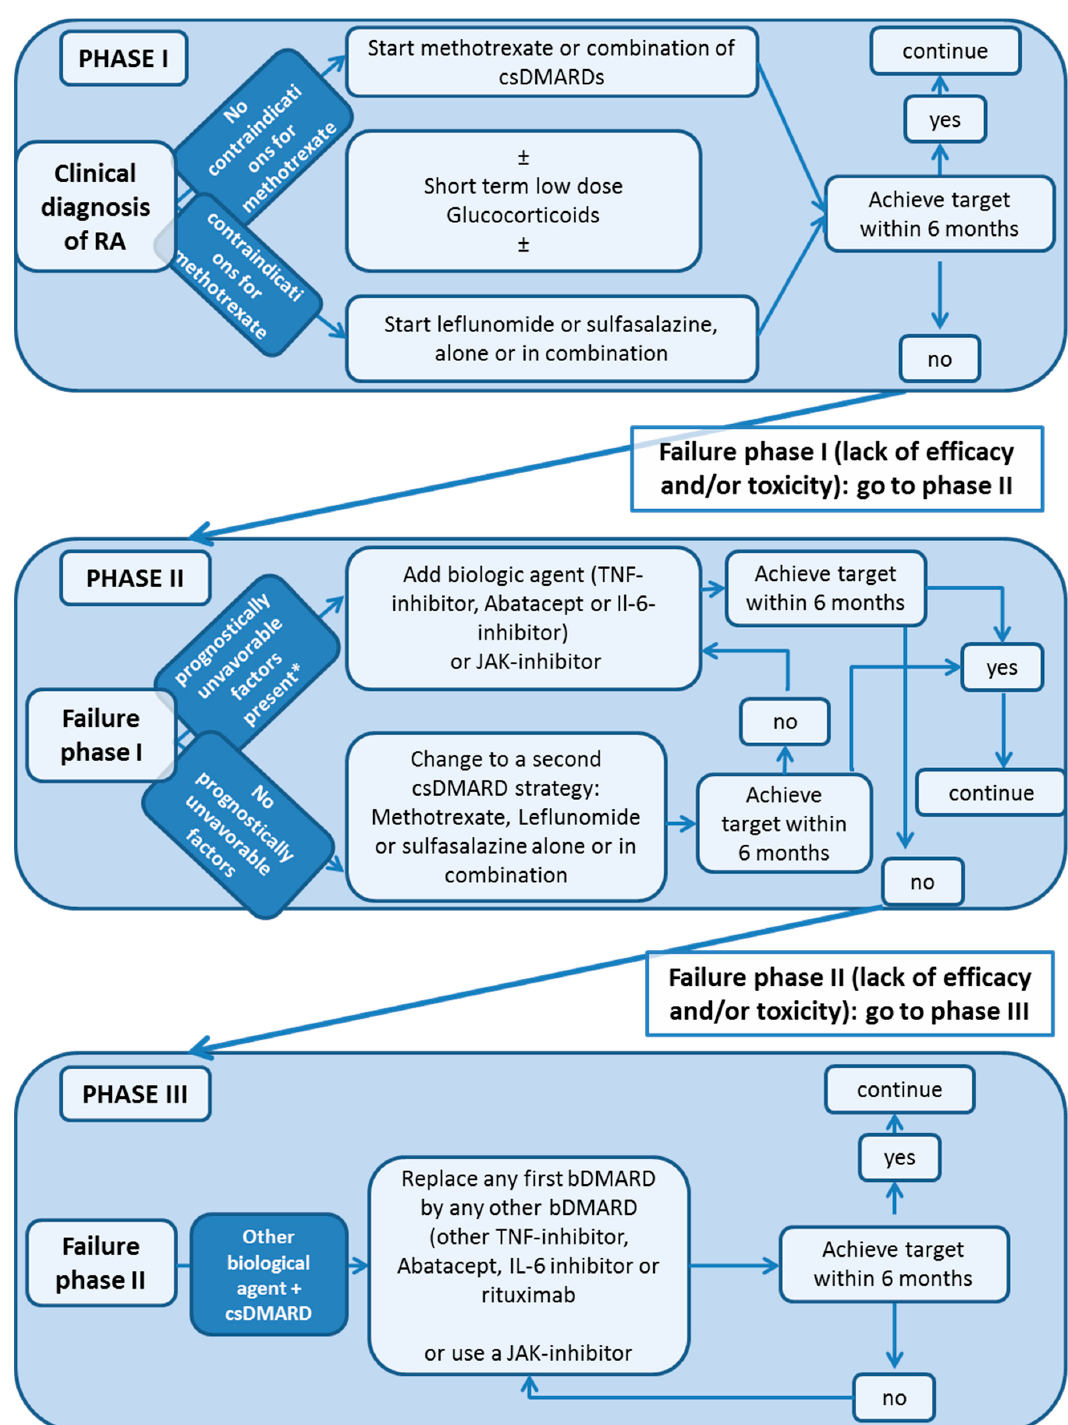
Figure 1. Algorithm adapted from the 2016 European League Against Rheumatism (EULAR) recommendationson rheumatoid arthritis (RA) management. bDMARD, biological; bsDMARD, biosimilar DMARDs; csDMARDs, conventional synthetic DMARDs; DMARDs disease modifying amtirheumatic drug; IL, Interleukin; MTX, methotrexate; TNF, tumor necrosis factor; tsDMARDs, targeted synthetic